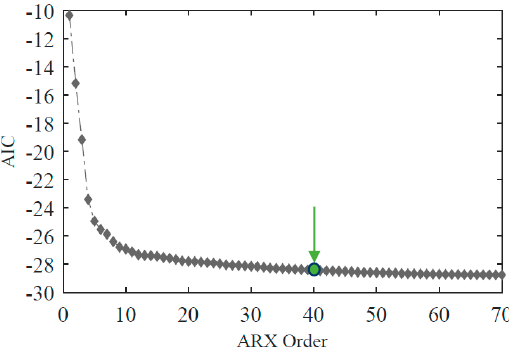
Figure 12. ARX model order.